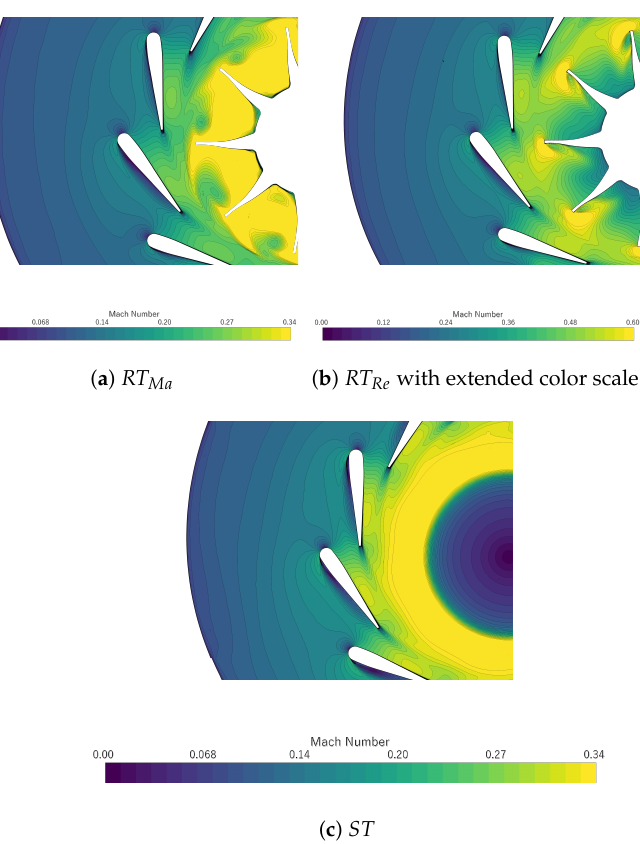
Figure 5. Mach number distribution at stator midspan. ST & RT. VGT60. 0.5 mm tip height.